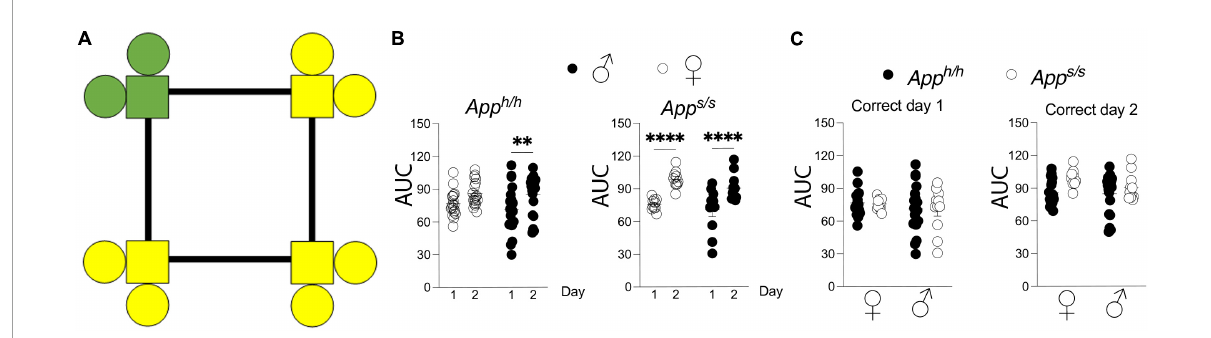
FIGURE1 Place learning analysis of App h / h and App s / s rats. (A) Schematic of operant corner, with “correct” corner in green and incorrect in yellow. (B) Area under the “correct” learning curve analysis for individual rats stratified by each day of the drinking session. Data are represented as mean ± SEM and were analyzed by two–way RM ANOVA followed by post-hoc Sidak’s multiple comparisons test when ANOVA showed significant differences ( App h / h rats: day factor, F ( 1 , 35 ) = 14.23, P = 0.0006; sex factor, F ( 1 , 35 ) = 0.5230, P = 0.4744; day × sex interaction, F ( 1 , 35 ) = 0.5370, P = 0.4686; post-hoc Sidak’s multiple comparisons test, females day 1 vs. day 2 P = 0.0806, males day 1 vs. day 2 P = 0.0054. App s / s rats: day factor, F ( 1 , 19 ) = 74.29, P < 0.0001; sex factor, F ( 1 , 19 ) = 1.784, P = 0.1974; day × sex interaction, F ( 1 , 19 ) = 0.3865, P = 0.5415; post-hoc Sidak’s multiple comparisons test, females day 1 vs. day 2 P < 0.0001, males day 1 vs. day 2 P < 0.0001). (C) Area under the “correct” learning curve analysis for individual rats stratified by sex and genotype. Data are represented as mean ± SEM and were analyzed by two–way ANOVA followed by post-hoc Sidak’s multiple comparisons test when ANOVA showed significant differences. Correct day 1: sex factor, F ( 1 , 54 ) = 1.358, P = 0.2490; genotype factor, F ( 1 , 54 ) = 0.0246, P = 0.8760; sex × genotype interaction, F ( 1 , 54 ) = 0.0012, P = 0.9719. Correct day 2: sex factor, F ( 1 , 54 ) = 1.515, P = 0.2238; genotype factor, F ( 1 , 54 ) = 1.998, P = 0.0960; sex × genotype interaction, F ( 1 , 54 ) = 0.9083, P = 0.3448). We tested 18 female App h / h , 19 male App h / h , 10 female App s / s , and 11 male App s / s . No animals met the exclusion criteria of < 25 visits per drinking session, and none died during the behavioral experiments. ∗∗ P < 0.01, and ∗∗∗∗ P <